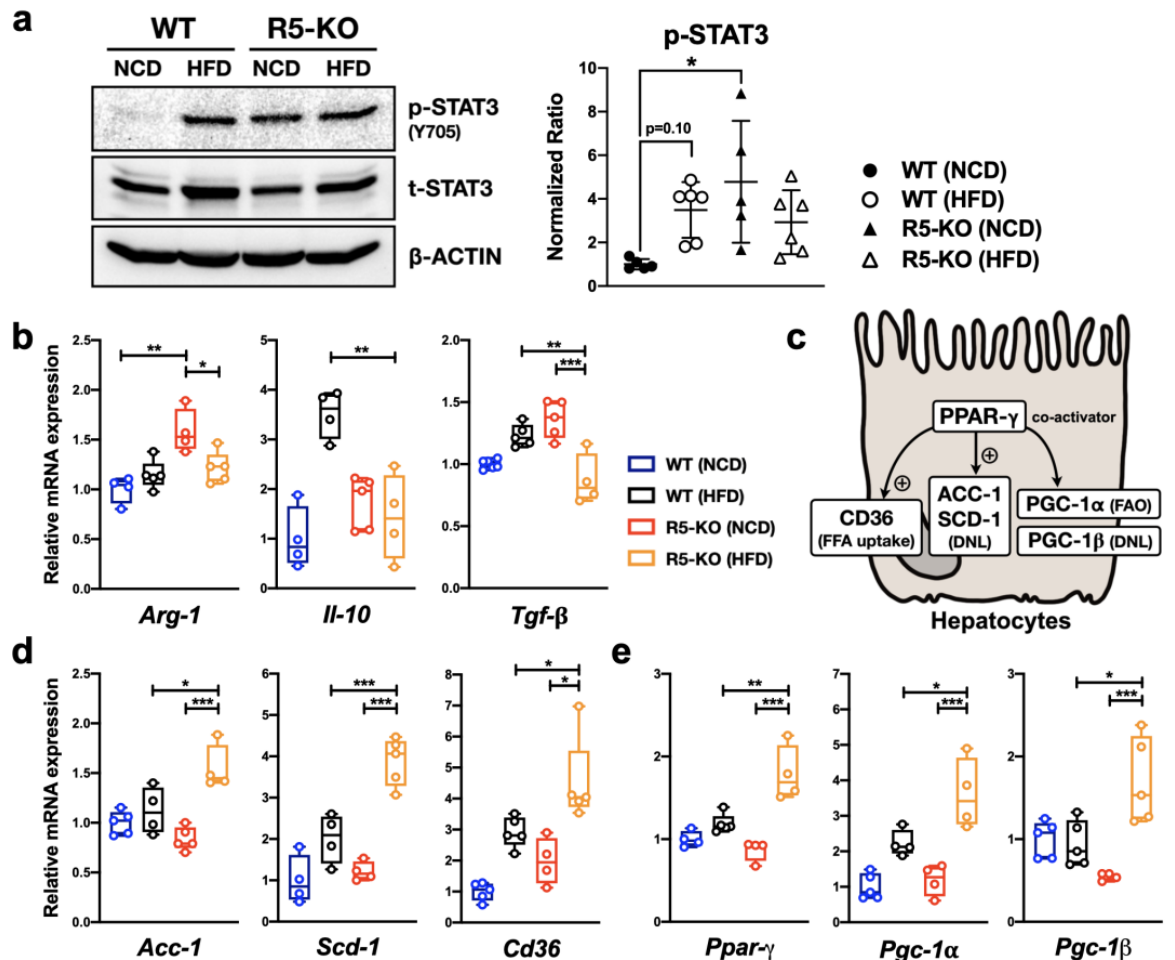
Figure 3. Global CCR5 deficiency causes altered hepatic STAT3 signaling and expression of cytokine genes and genes related to lipid metabolism. ( a ) Equal amounts of proteins from liver homogenates were subjected to SDS-PAGE followed by immunoblotting using antibodies specific for phosphorylated and total STAT3. Normalization was confirmed by β -ACTIN immunoblotting. Signal intensity was quantified for statistical analysis. The signal of phosphorylated STAT3 was normalized to total STAT3 and set the average value of WT (NCD) to 1. The levels of hepatic transcripts of genes related to g-MDSC functions ( b ), lipogenesis ( d ), and Ppar- γ with its co-activators ( e ) were determined by real-time PCR. Expression was normalized to the 36b4 reference gene and further normalized to the average value of the WT (NCD) group (n = 4-6). ( c ) A schematic diagram of targeted lipid-regulatory genes with their reported functions in NAFLD. FFA, free fatty acid; DNL, de novo lipogenesis; FAO, fatty acid oxidation. *, p < 0.05; **, p < 0.005; ***, p <